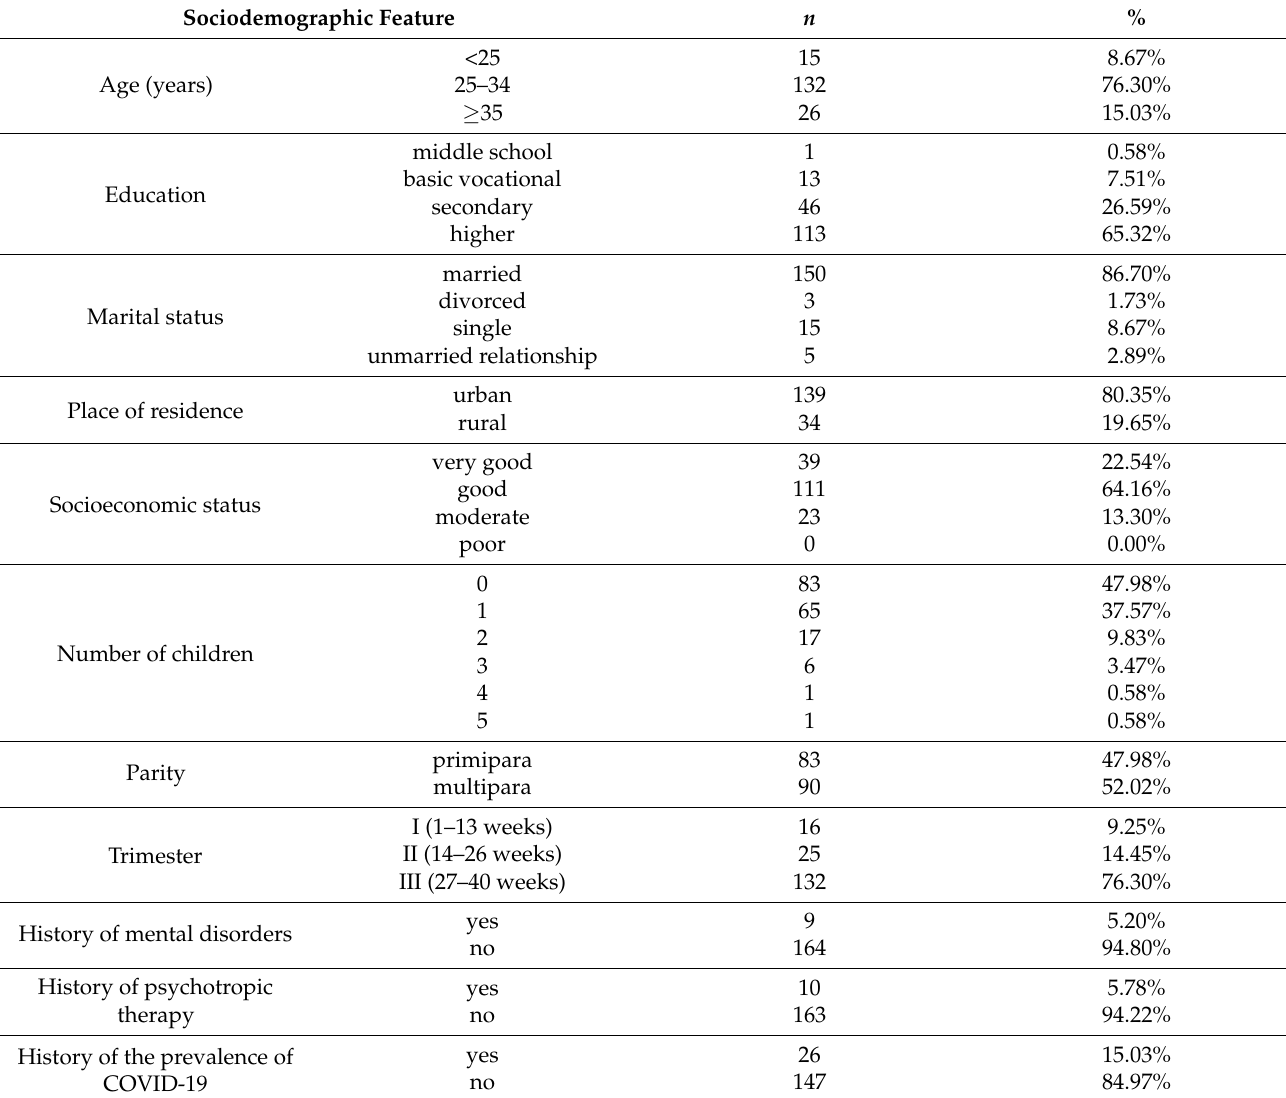
Table 1. Sociodemographic characteristics of respondents.